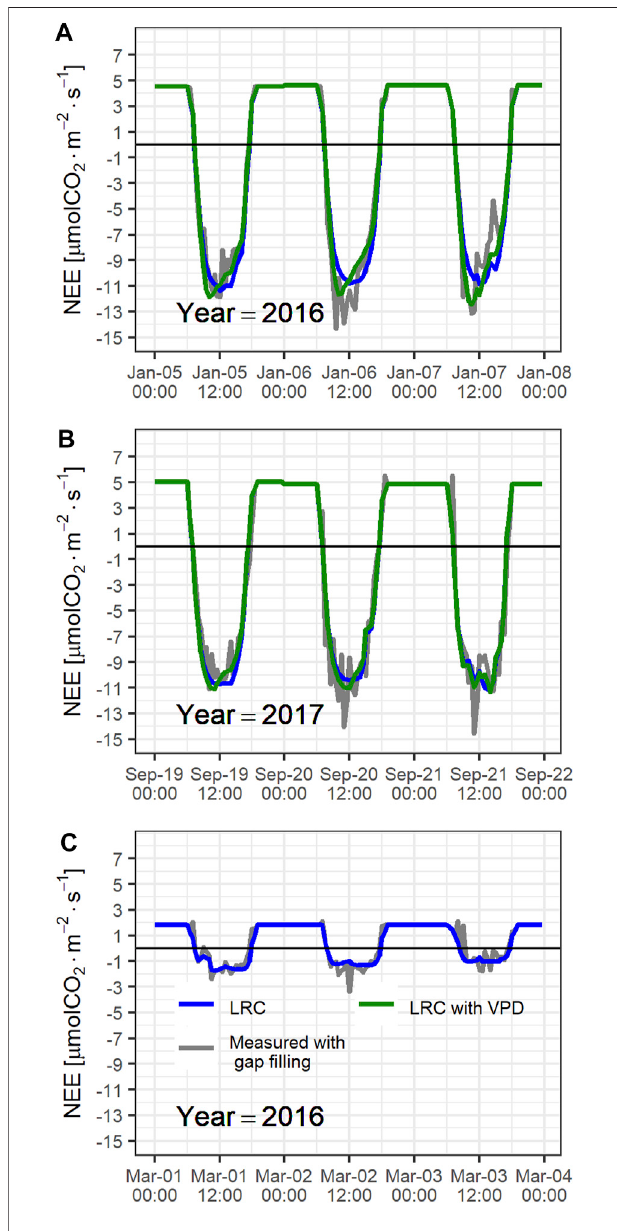
FIGURE 3 | Daily cycle of carbon fl uxes (NEE) for 3 consecutive days during (A) earlyinthedryseasonof2016; (B) thewetseasonof2017,and (C) late in the dry season of 2016. Half-hourly fl uxes after gap fi lling procedures are shown in gray, light response curves adjusted for each day are shown in blue, and light response curves adjusted for each day including VPD effects are shown in